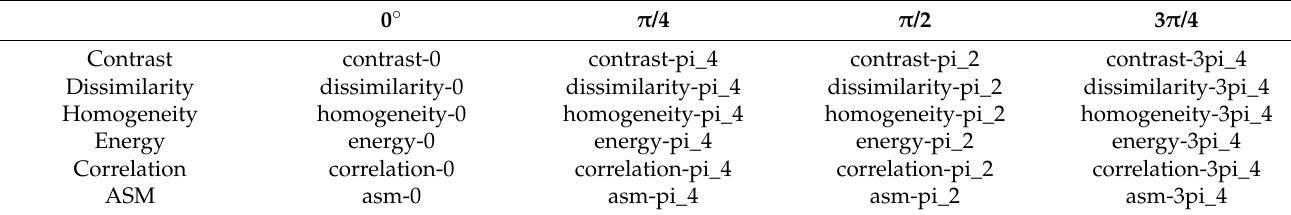
Table 2. GLCM texture